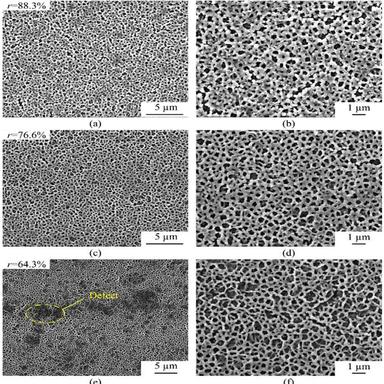
SEM morphologies of the multi-line scanned regions obtained under various overlap rates (P = 1.48 W, v = 10 mm/s, f = 700 kHz): (a) r = 88.3 %, (c) r = 76.6 %, and (e) r = 64.3 %. (b), (d), and (f) are the local enlarged images of Fig. 2(a), (c), and (e), respectively.